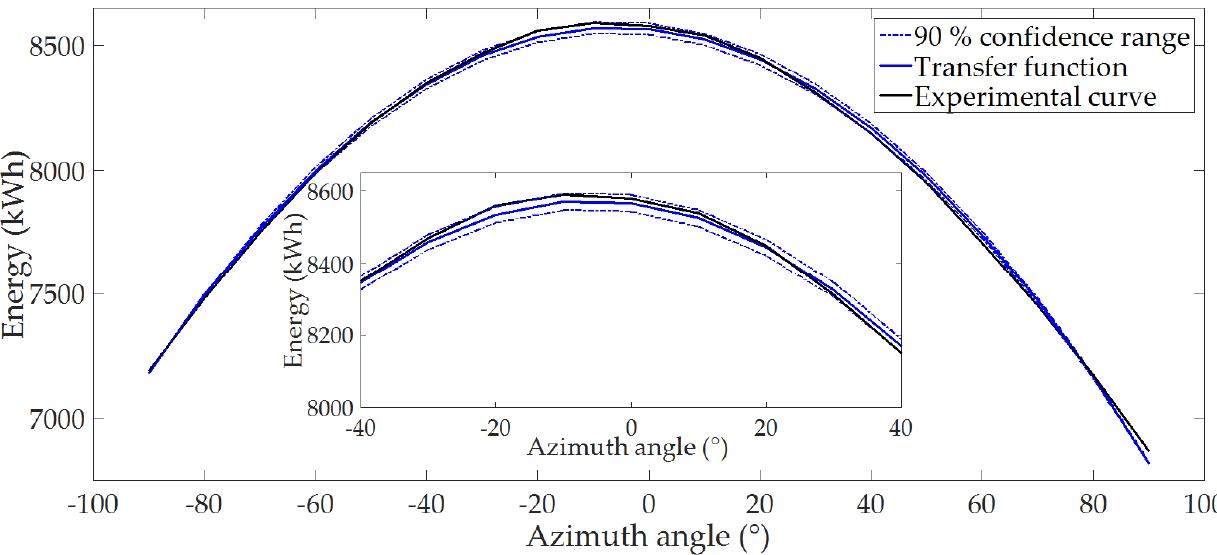
Figure 14. Comparison of relations between the energy and azimuth angle with 90% confidence for azimuth angle range ( − 90–90°) and detail for range ( − 40–40°).